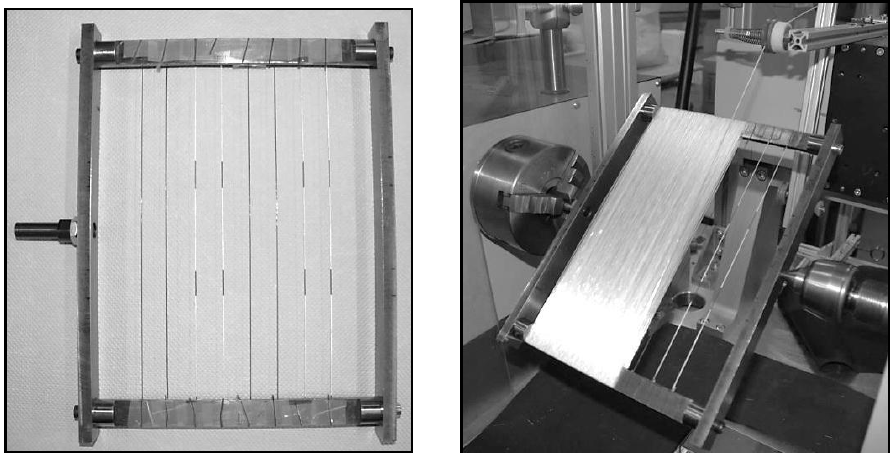
Figure 1. Sensor fibre bundle (204 nanostructured glass filaments) placement in a rectangular mandrel (with ( Left ) and without ( Right ) silver paint pattern for improved conductivity) with adhesive tape during the glass fibre (GF)/ polypropylene (PP) unidirectional composite winding process.